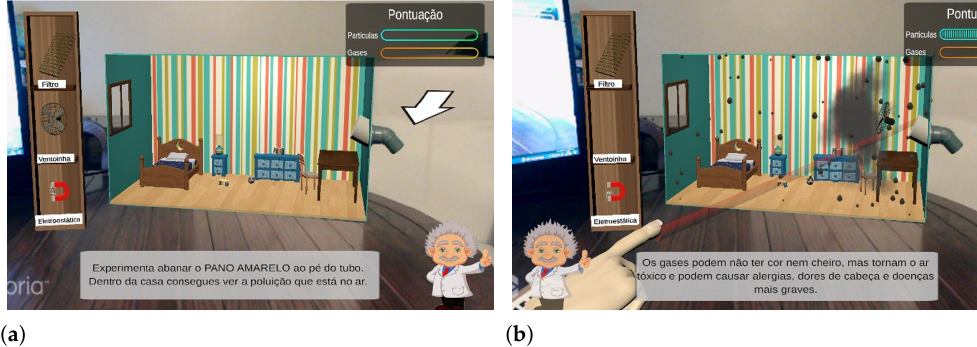
Figure 11. Interaction with NPC. ( a ) NPC giving the initial tutorial. Subtitles translation: Try shaking the yellow cloth near the tube. Inside the house you can see the pollution that is in the air . ( b ) NPC providing information after the first release of gas/particles. Subtitles translation: Gases may be colorless and odorless, but they are toxic and can cause allergies, headaches and more serious illnesses